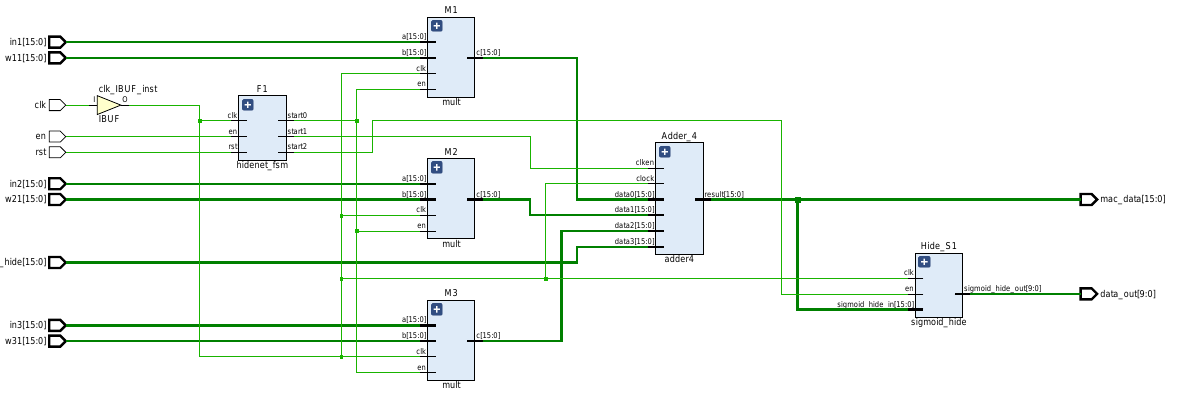
Figure 9. RTL schematic diagram of single